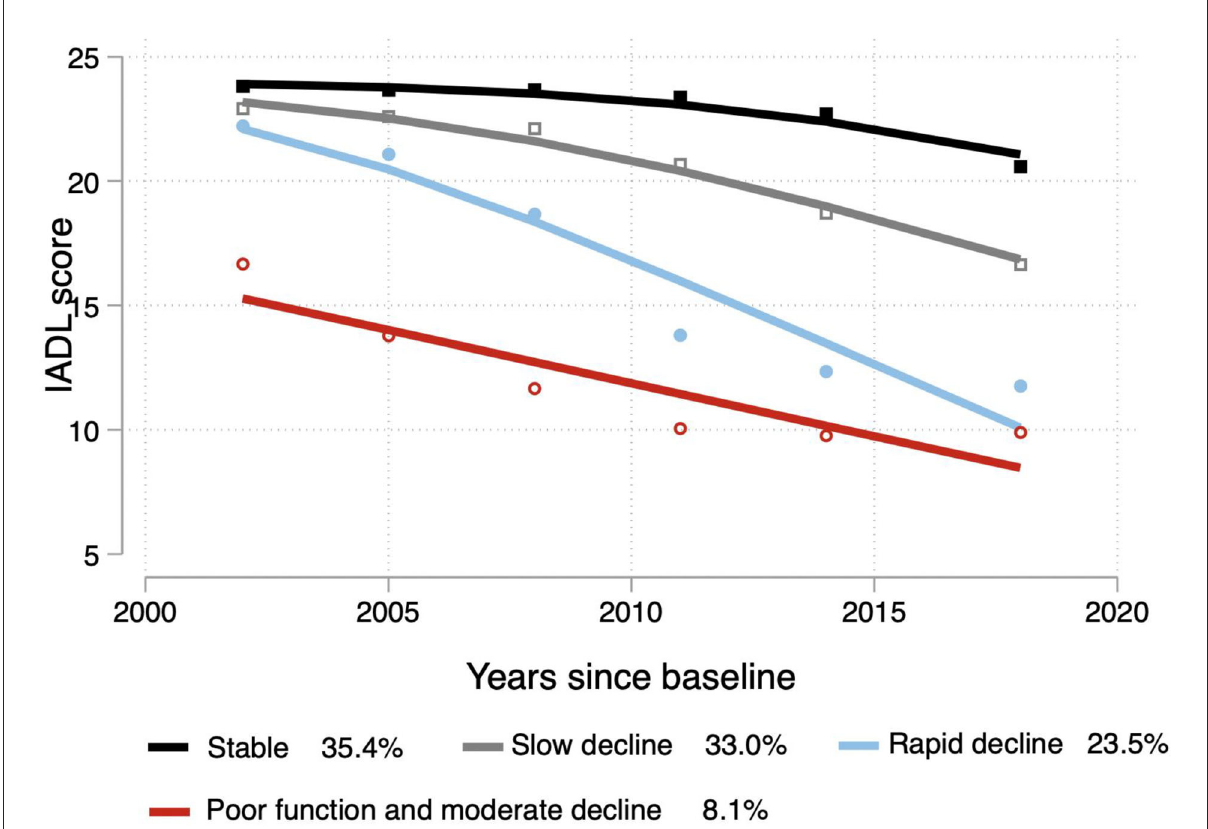
FIGURE2 Trajectories of the IADL scores. The solid lines (black: stable; gray: slow decline; blue: rapid decline; red: poor function and moderate decline) represent estimated